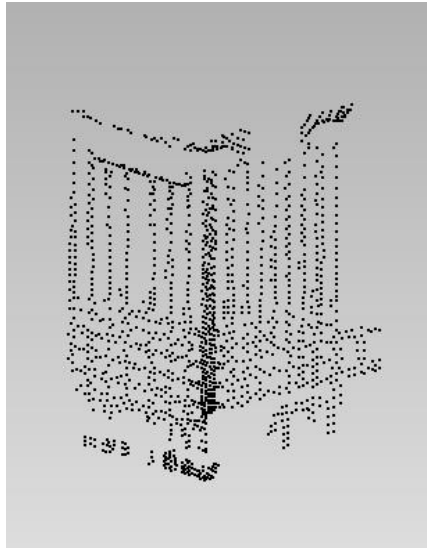
Fig4-3.. Comparison Of Lidar And TomoSAR Acquisition Of